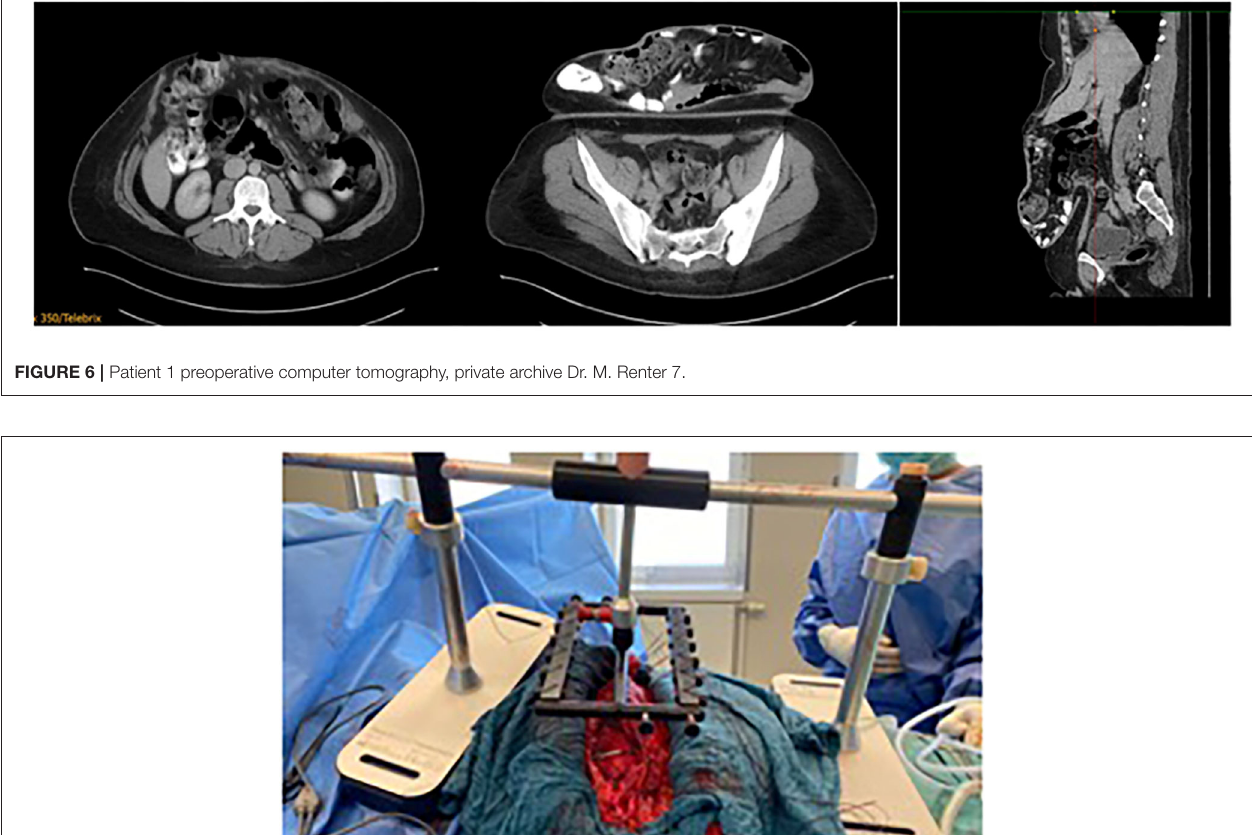
( r = 0.62). In the 13 patients pre-treated with BTA, the average fascial distance decreased by 9.9 cm, from 16.1